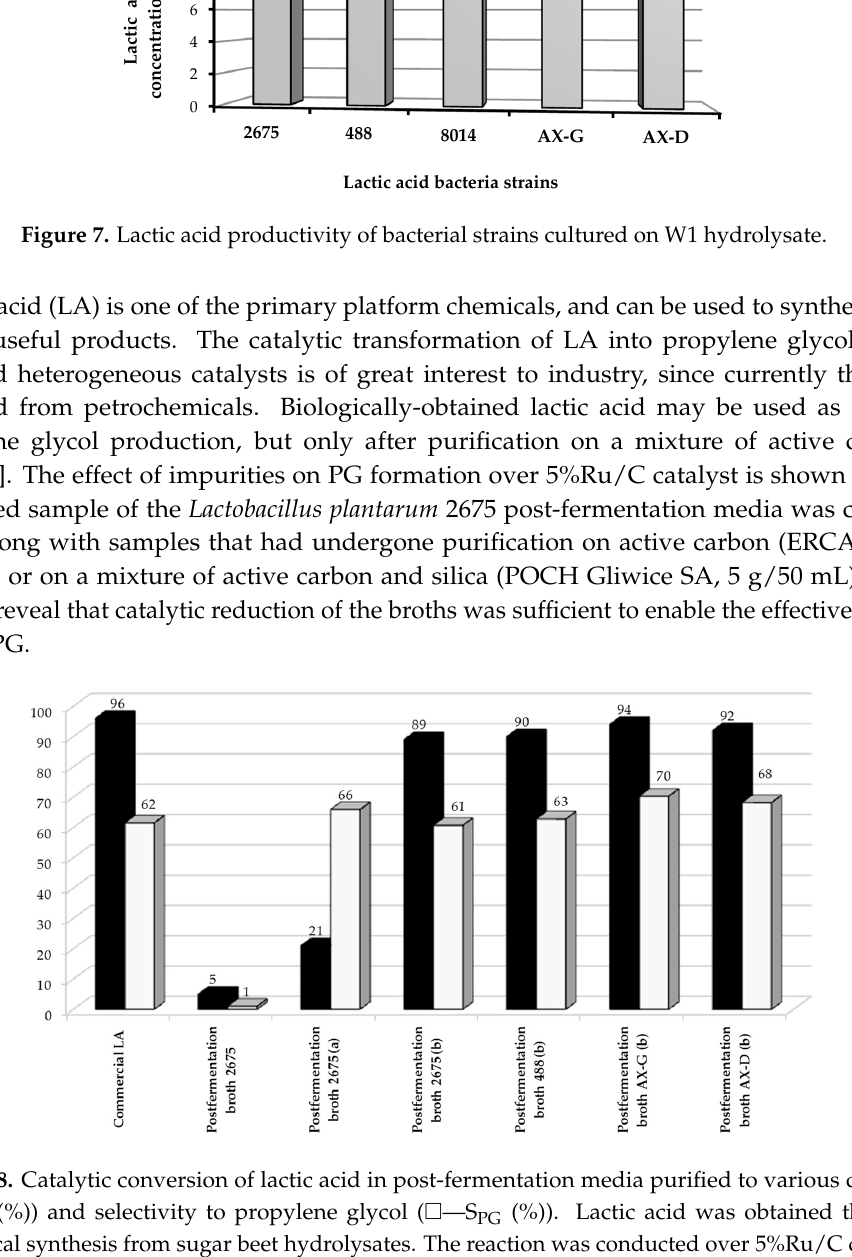
Figure 7. Lactic acid productivity of bacterial strains cultured on W1 hydrolysate.